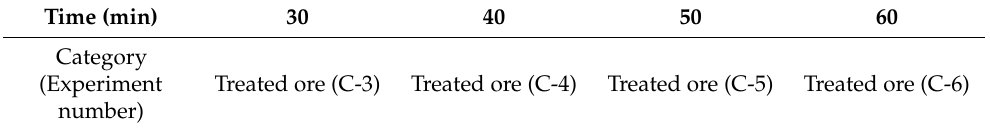
Table 5. Experimental design for the effect of the ultrasonic action time on desulfurization rate. Time